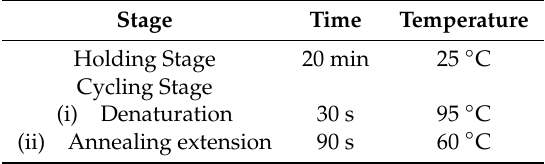
Table 6. Cycling condition for telomerase activity